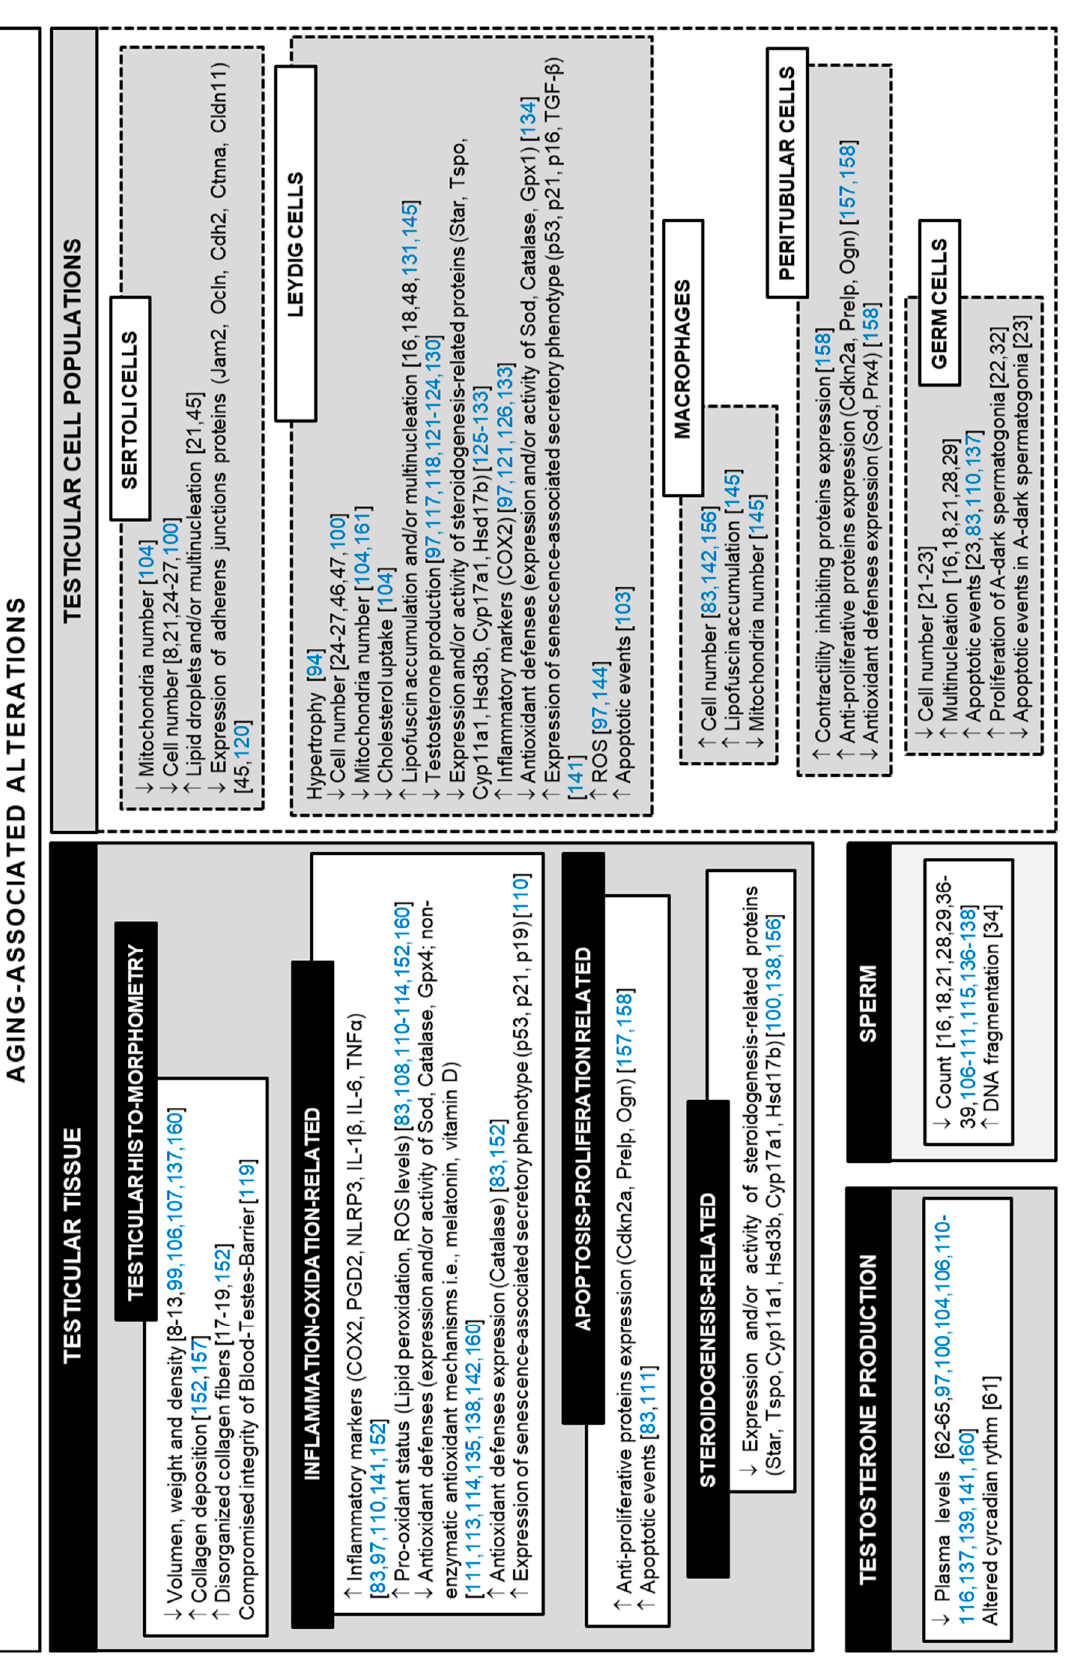
Figure 1. Primary alterations reported in the testis of aging men and in aged experimental animals. Corresponding references are listed between brackets (black, data on human samples; blue, data on animal models).